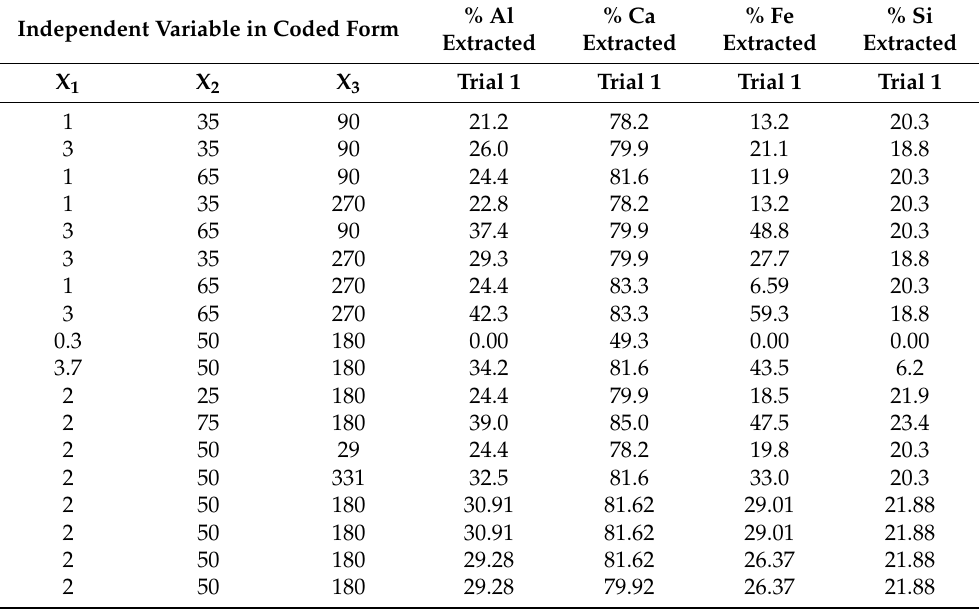
Table 5. Percent extraction of Al, Ca, Fe and Si corresponding to each combination of independent